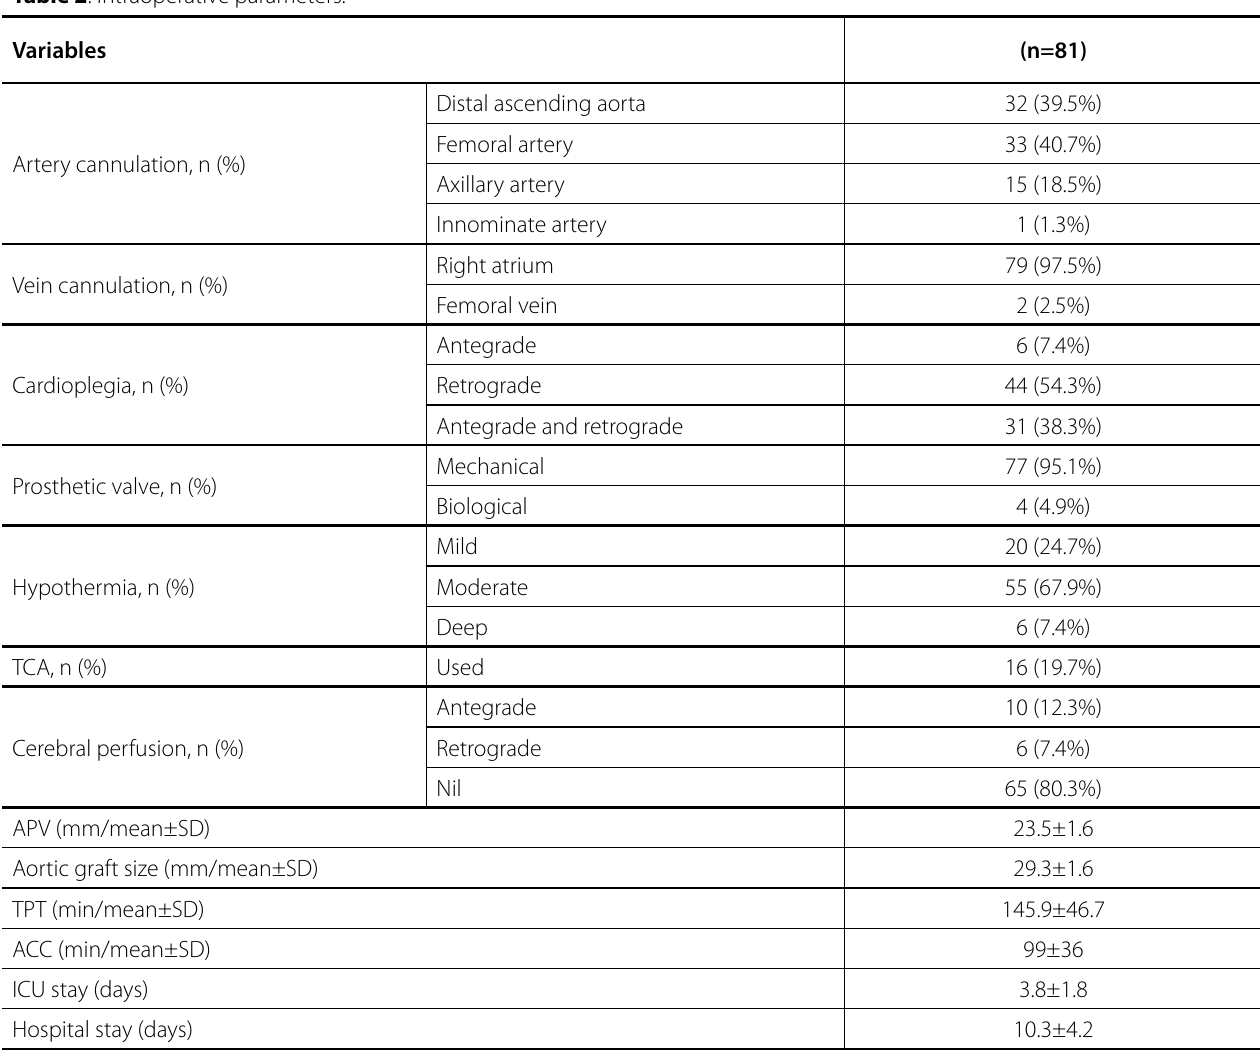
Table 2 . Intraoperative